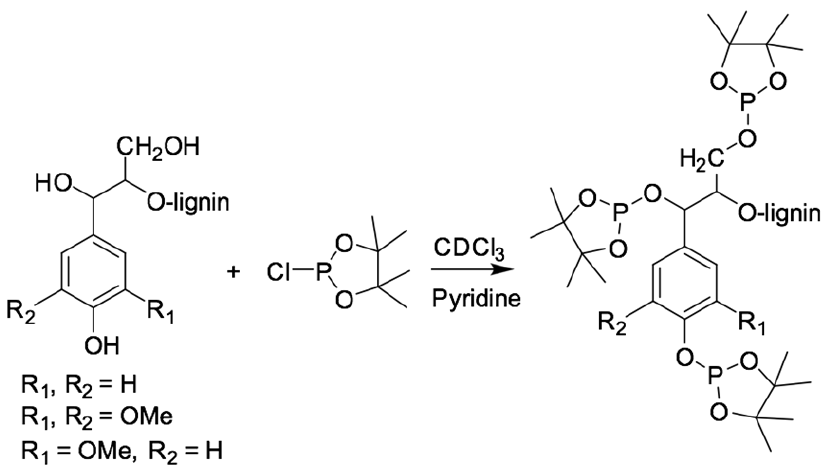
Figure 2. Phosphitylation of hydroxyl groups in lignin with TMDP reagent.